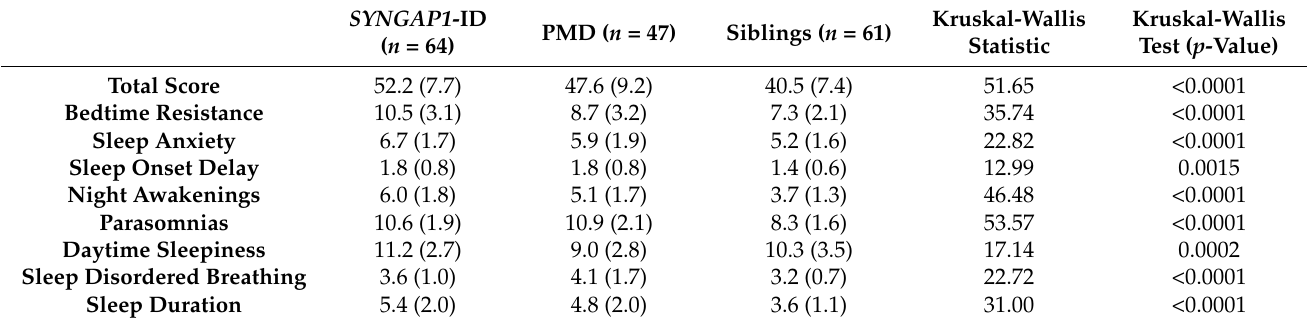
Figure 1. Total ( A ) and sub-scale scores for SYNGAP1 -related intellectual disability ( SYNGAP1 -ID), Phelan–McDermid syndrome (PMD) and unaffected siblings (Siblings). Sub-scales: ( B ) Bedtime Resistance, ( C ) Sleep Anxiety, ( D ) Sleep Onset Delay, ( E ) Night Awakenings, ( F ) Parasomnias, ( G ) Daytime Sleepiness, ( H ) Sleep Disordered Breathing, ( I ) Sleep Duration. Dunn’s multiple comparisons test * p < 0.05, ** p < 0.01, *** p < 0.001, **** p < 0.0001. Heavy dashed line is median, light dashed line is quartile. Table 2. Combined data from CSHQ, mean (standard